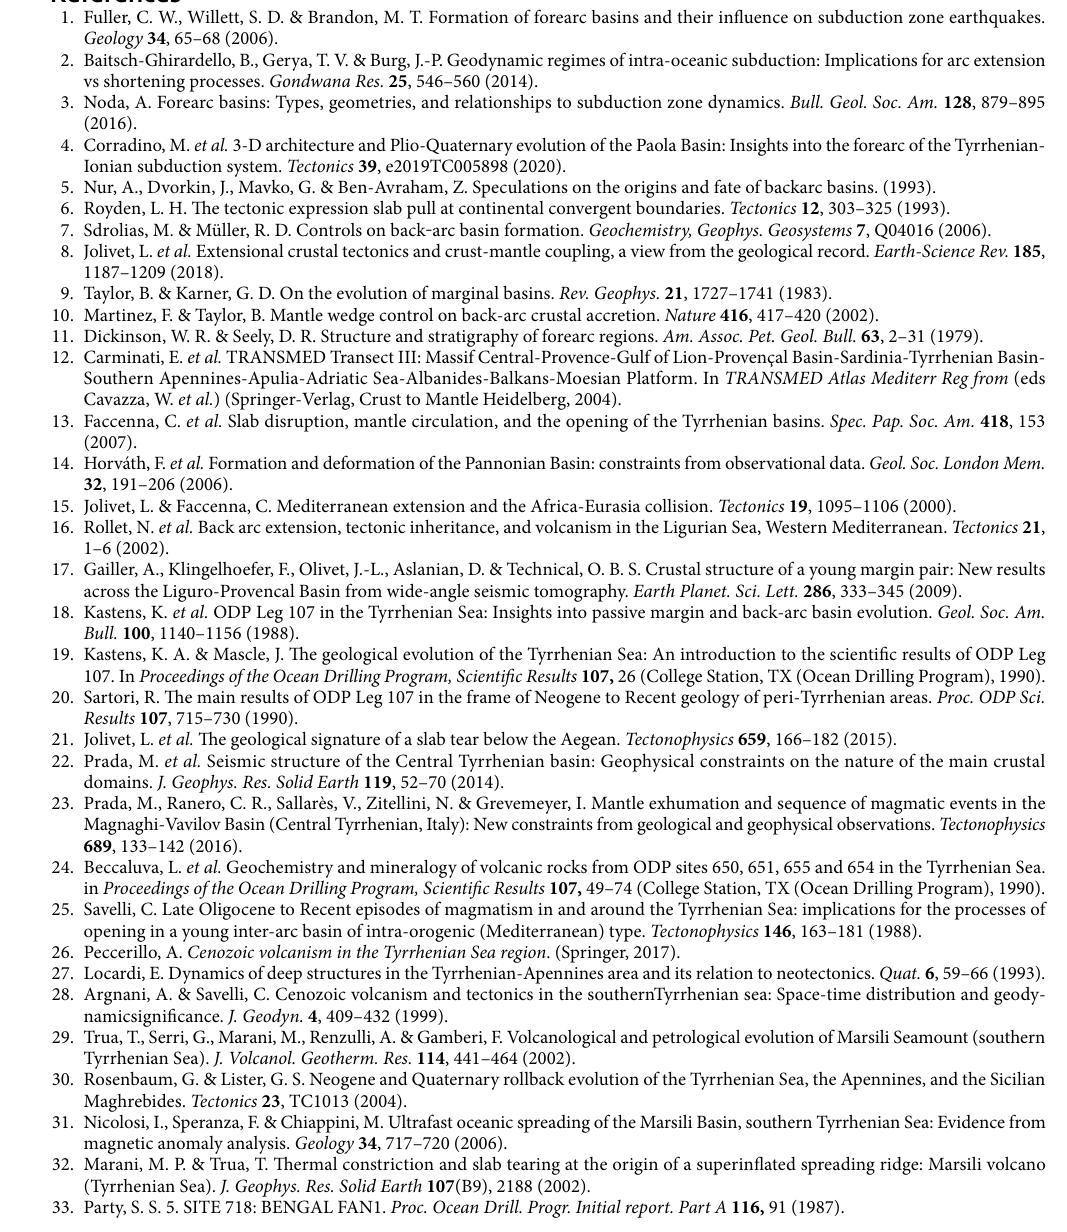
where α and β denote the thermal expansion and compressibility coefficients,